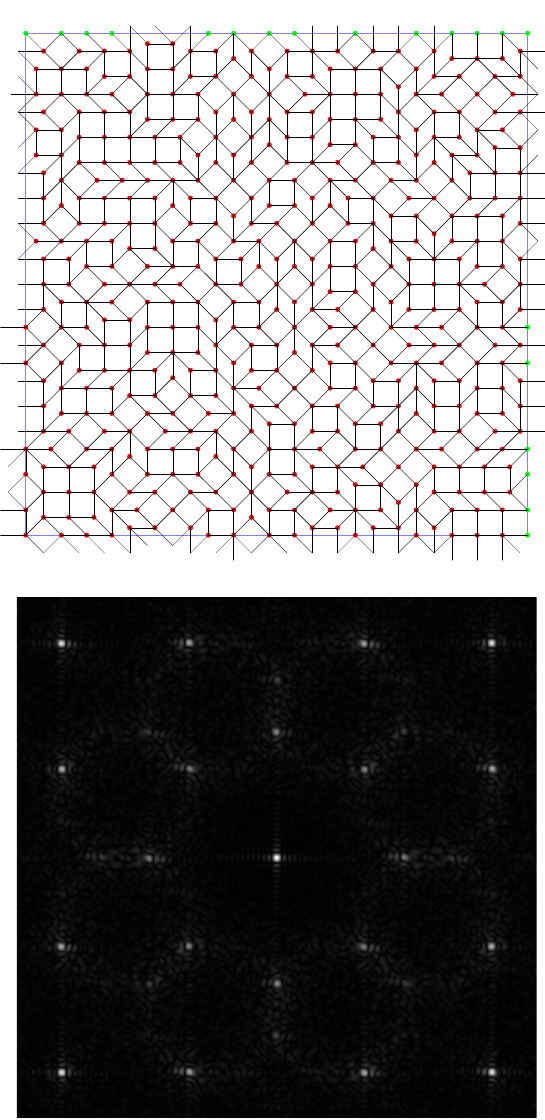
Figure 2. Finite patch of the Ammann–Beenker random tiling (top) and its di ff raction